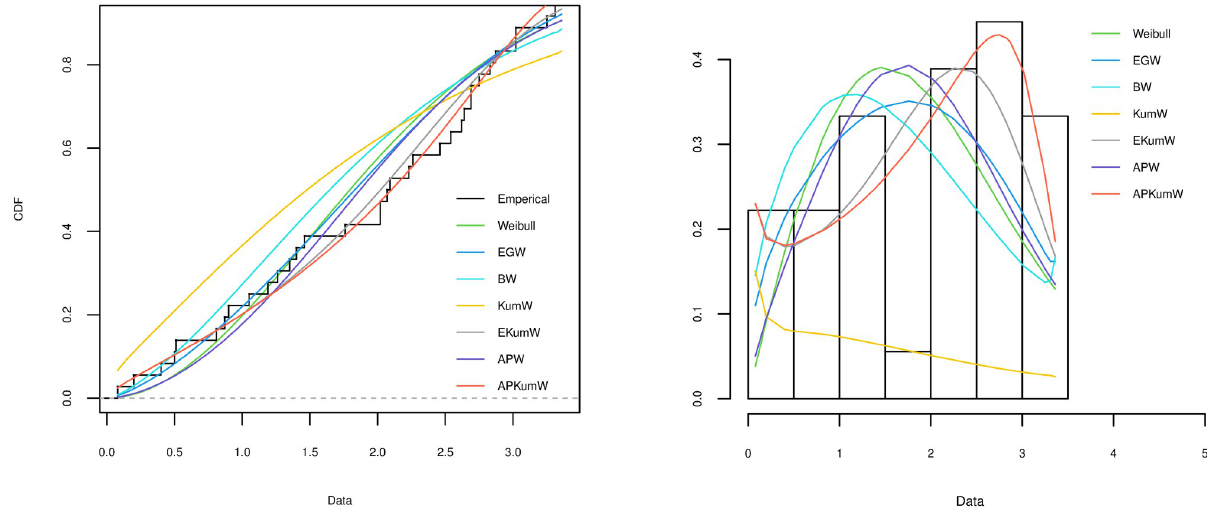
Fig 5. Theoretical and empirical cdf and pdf comparison of the bladder cancer I data.